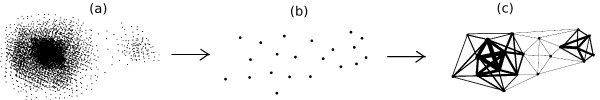
Data reduction scheme. (a) Running spectral clustering is impractical on data that contains thousands of points. (b) Faithful sampling picks up a reasonable subset of points such that running spectral clustering is possible on them. However, all information about the local density is lost by considering only these sample points. (c) We assign weights to the edges of the graph; the edges between the nodes in denser regions are weighted considerably higher. The information about the local density is retrieved in this way.